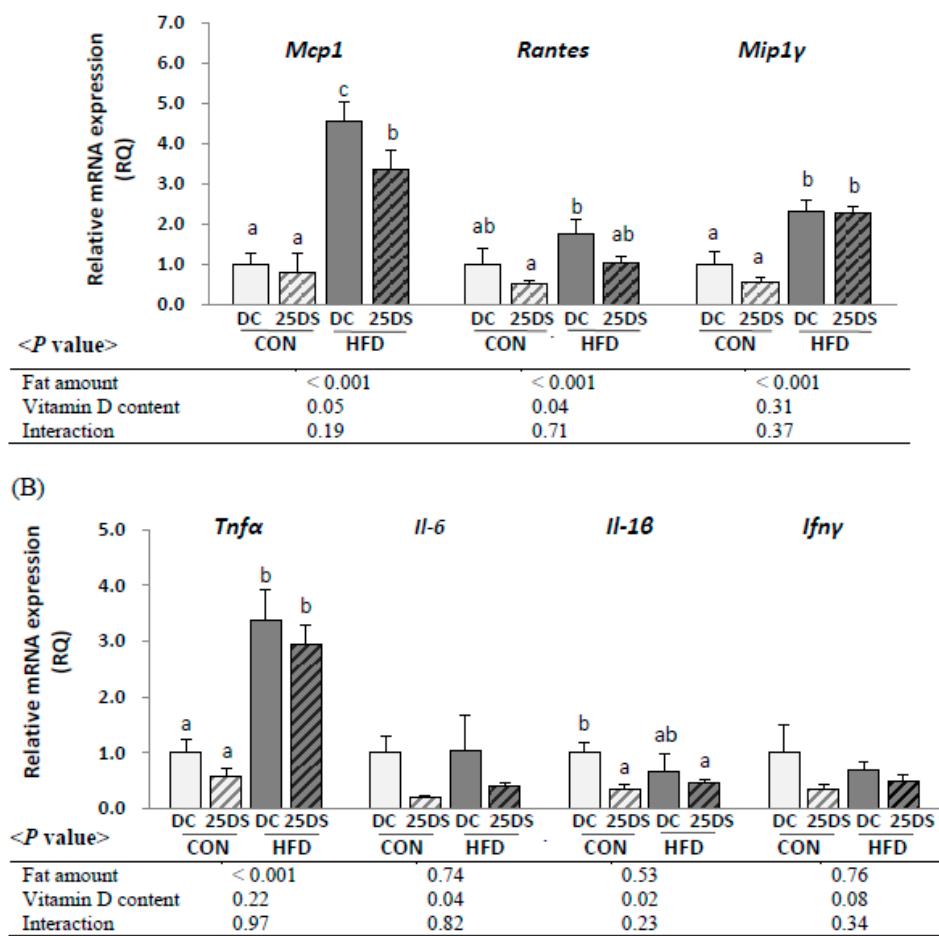
Figure 1. The mRNA levels of pro-inflammatory ( A ) chemokines and ( B ) cytokines in epididymal adipose tissue. Data are presented as mean ± SEM, n = 6~8 for each group. Two-way ANOVA was used to determine the significant effects of fat and vitamin D content and an interaction. ab Different superscripts indicate significant difference ( p < 0.05) by Duncan’s multiple range test. CON: 10% kcal fat diet; HFD: 45% kcal fat diet; DC: 1000 IU vitamin D/kg diet; 25DS: 25,000 IU vitamin D/kg diet. Mcp-1 , monocyte chemoattractant protein 1; Rantes, regulated on activation, normal T cell expressed and secreted; Mip-1 γ , macrophage inflammatory protein-1 gamma; Il-6 , interleukin 6; Il-1 β , interleukin 1beta; Tnf- α , Tumor necrosis factor ; Ifn- γ , interferon gamma. 3.5. Subpopulation and the Number of Immune cells of SVCs in Visceral Adipose Tissue The effects of a high-fat diet and vitamin D supplementation at a dose of 10,000 IU/kg on subpopulations of immune cells in SVCs were determined. The number of each type of immune cell per gram of visceral adipose tissue and total cell numbers are shown in Figure 2 and Table S5. The number of SVCs per g from visceral adipose tissue was significantly higher in the HFD groups than in the CON groups. Numbers of macrophages and NK cells (number/g tissue and total number) in SVCs were significantly higher in the HFD groups compared with the CON groups; however, there was no significant effect of vitamin D supplementation (Figure 2 and Figure S2). Numbers of B cells, CD4+ T cells, and CD8+ T cells/ g tissue were not different among groups (Figure 2), while the total number of CD4+ T cells was significantly higher in HFD groups than in CON groups (Table S5). The number of CD4+ T cells (numbers/g tissue and total numbers) tended to